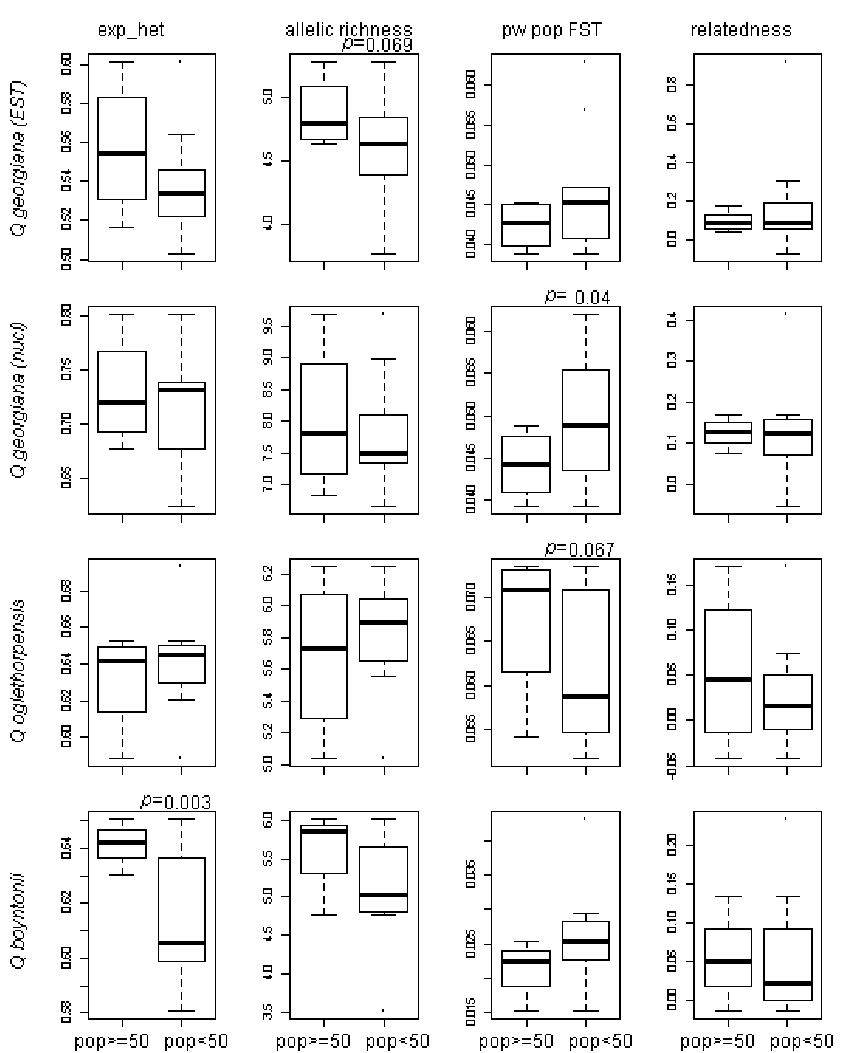
Figure A2. Box and whisker plots for each species by genetic summary. Each column of graphs represents different genetic summary statistics: (exp_het): expected heterozygosity; allelic richness; (pw pop FST): Pairwire population F ST ; and relatedness. Within each graph, the boxplot on the right represents populations with greater than or equal to 50 individuals (pop >= 50) and less than 50 individuals (pop < 50).